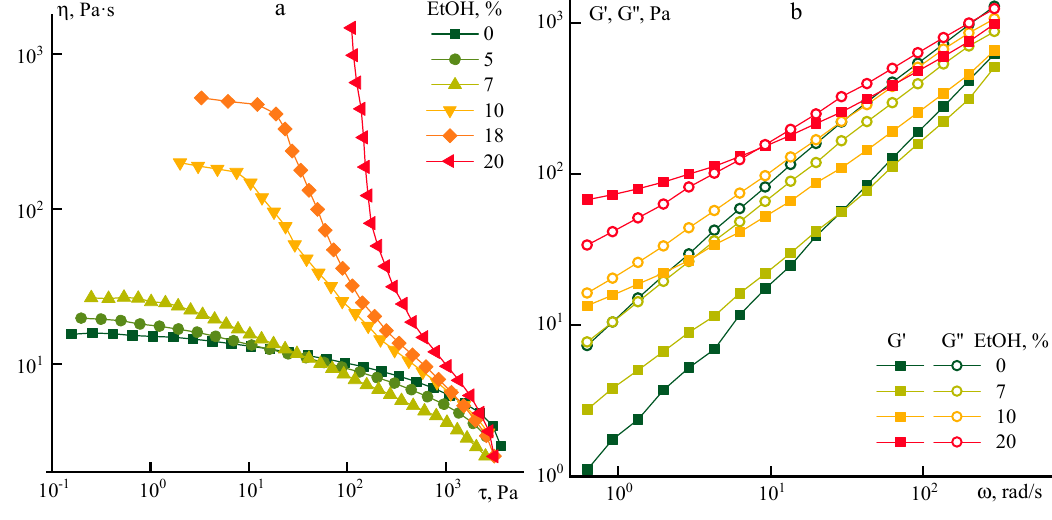
Figure 7. ( a ) Flow curves and ( b ) frequency dependences of moduli of prepolymer-poly- (o-aminophenylene)naphthoylenimide (PANI)-O solutions with ethanol addition. Low ethanol concentrations (up to ~7%) enhance the viscosity anomaly. Moreover, the viscosity increases in the region of low stresses whereas it decreases in the region of high stresses in comparison with the flow curve of the PANI-O solution in NMP. At the same time, a narrowing of the maximal Newtonian viscosity plateau begins to be observed, i.e., the system exhibits “non-Newtonian” properties over a wider range of shear stresses. Starting from ~10% of ethanol, the absolute values of the viscosity at low stresses increase, reaching a centuple increase for an 18% solution compared to the initial solution, and at 20% of ethanol content, a distinct yield point appears on the flow curve.